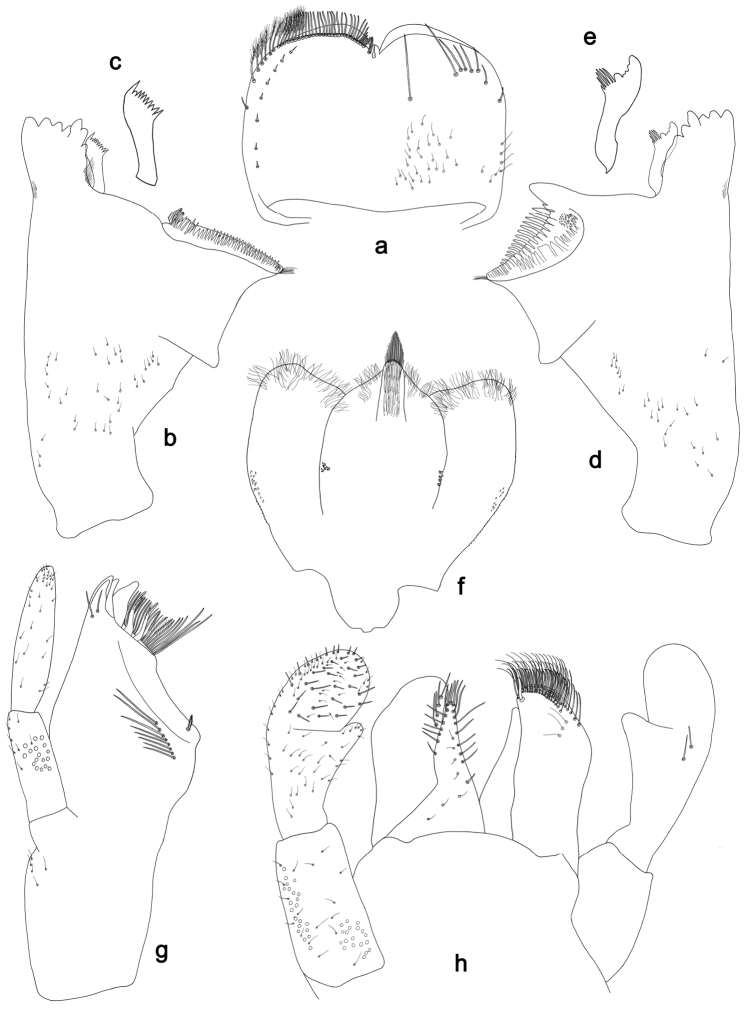
Labiobaetisgindroi sp. n., larva morphology: a Labrum b Right mandible c Right prostheca d Left mandible e Left prostheca fHypopharynxg Maxilla h Labium.